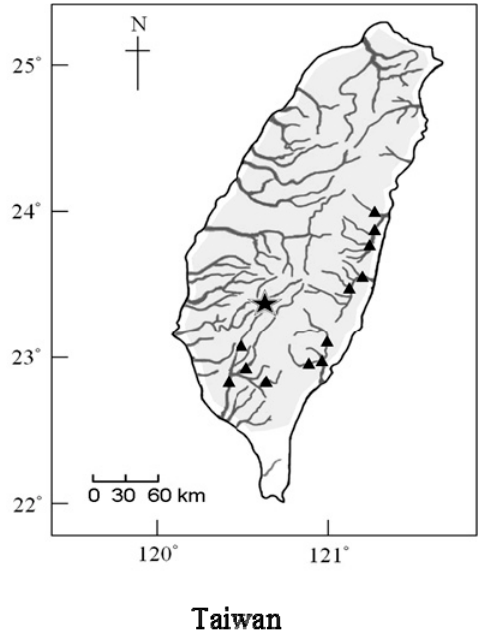
Figure 1. Distribution of Onychostoma barbatulum (gray area) and O. alticorpus (black triangles). Asterisk indicates the sampling location.